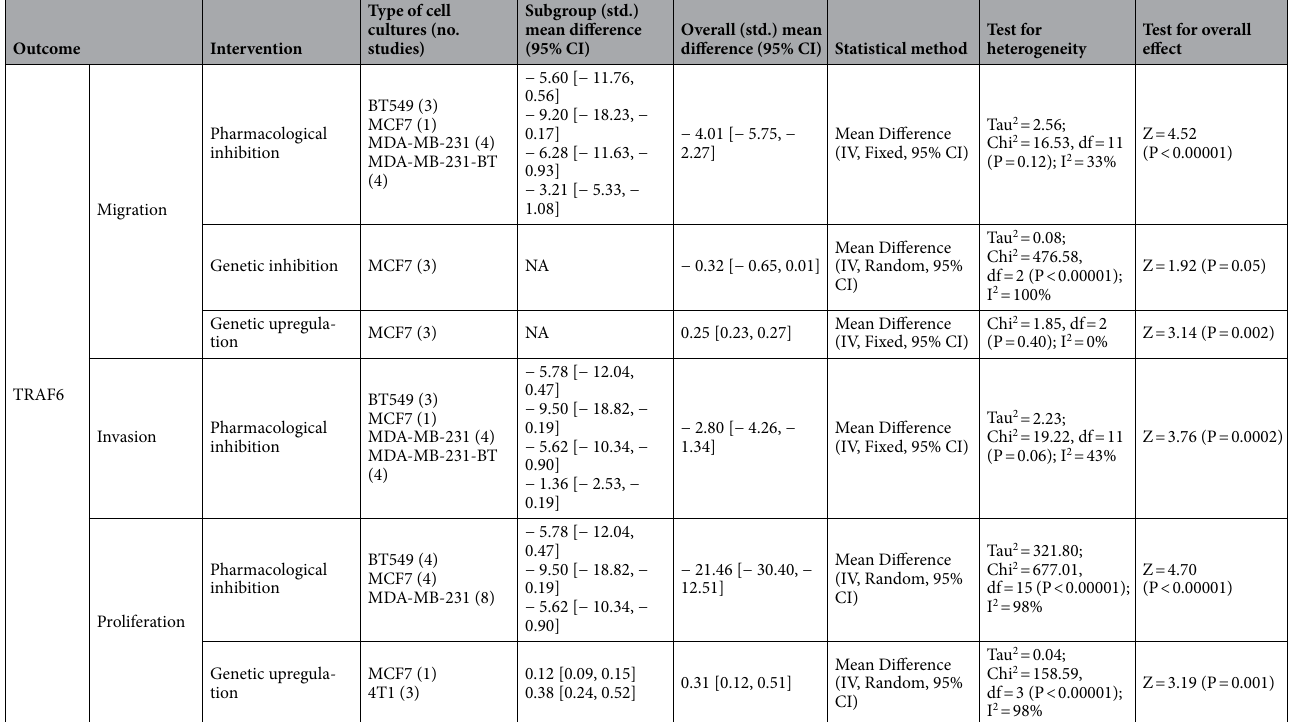
Table 2. Summary of meta-analysis of included studies showing significant association of in vitro breast cancer cell behaviour and modulation of TRAF2/4/6. The analysis shows the mean difference or standard mean difference of different studies comparing the effects of the TRAF6 pharmacological inhibition, genetic inhibition or upregulation on cell migration as assessed by trans-well assay or wound healing assay, cell invasion as assessed by trans-well assay and proliferation as assessed by cell viability assay. Std., standardised; IV, inverse-variance weighting; NA, not applicable. + Refers to studies using the same intervention which inhibit both TRAF2 and 4 on cell invasion, *refers to studies using the same intervention which inhibit both TRAF2 and 4 on cell invasion, £ intervention modulated the activity of both TRAF2 and